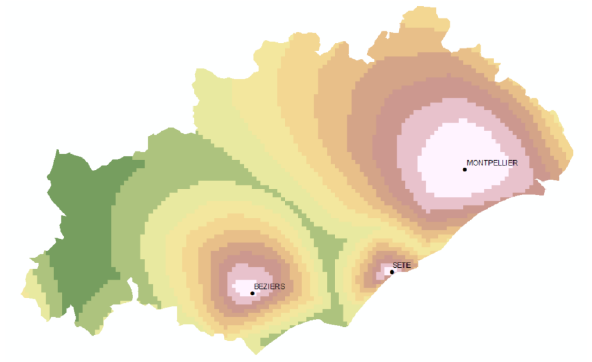
Figure 4. Probabilistic area of influence of the three main cities of the department of Hérault (France), using Huff model.